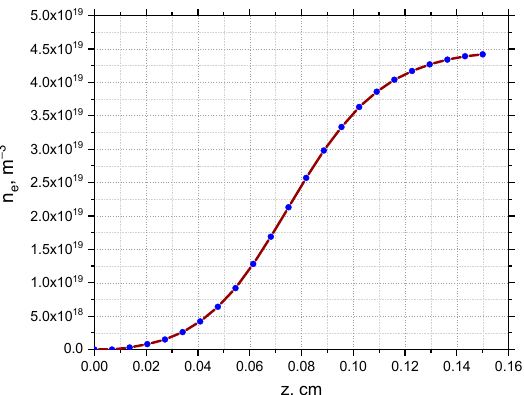
Figure 34. Experimental electron density profile for Globus-M2.